Question: Name the type of graph shown.
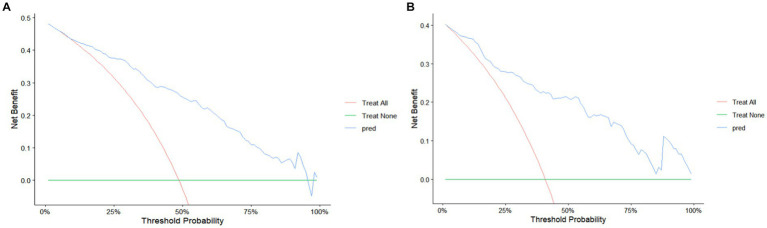
Answer: line